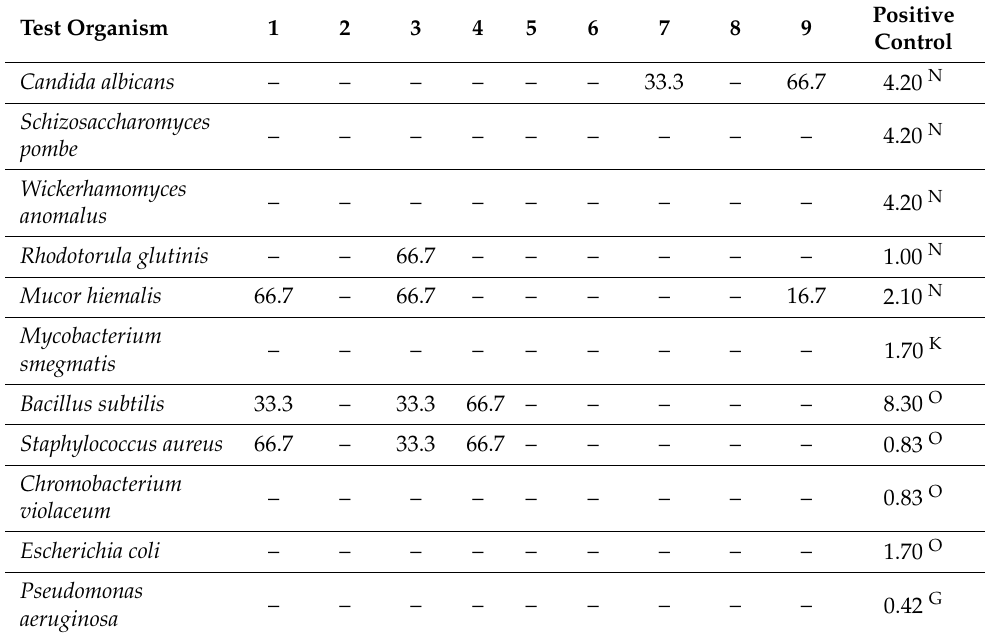
Table 3. Minimum inhibitory concentration (MIC, µ g/mL) of 1 – 9 against fungi and bacteria. Test